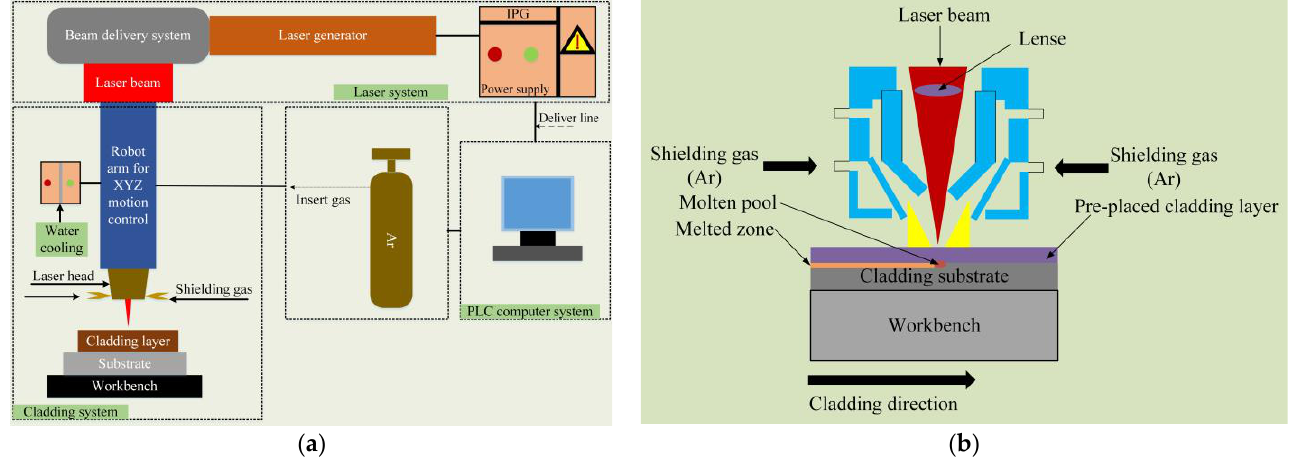
Figure 2. ( a ) Schematic illustration of laser cladding system; ( b ) pre-placed powder method of laser cladding. Table 4. Parameter variables of laser cladding.